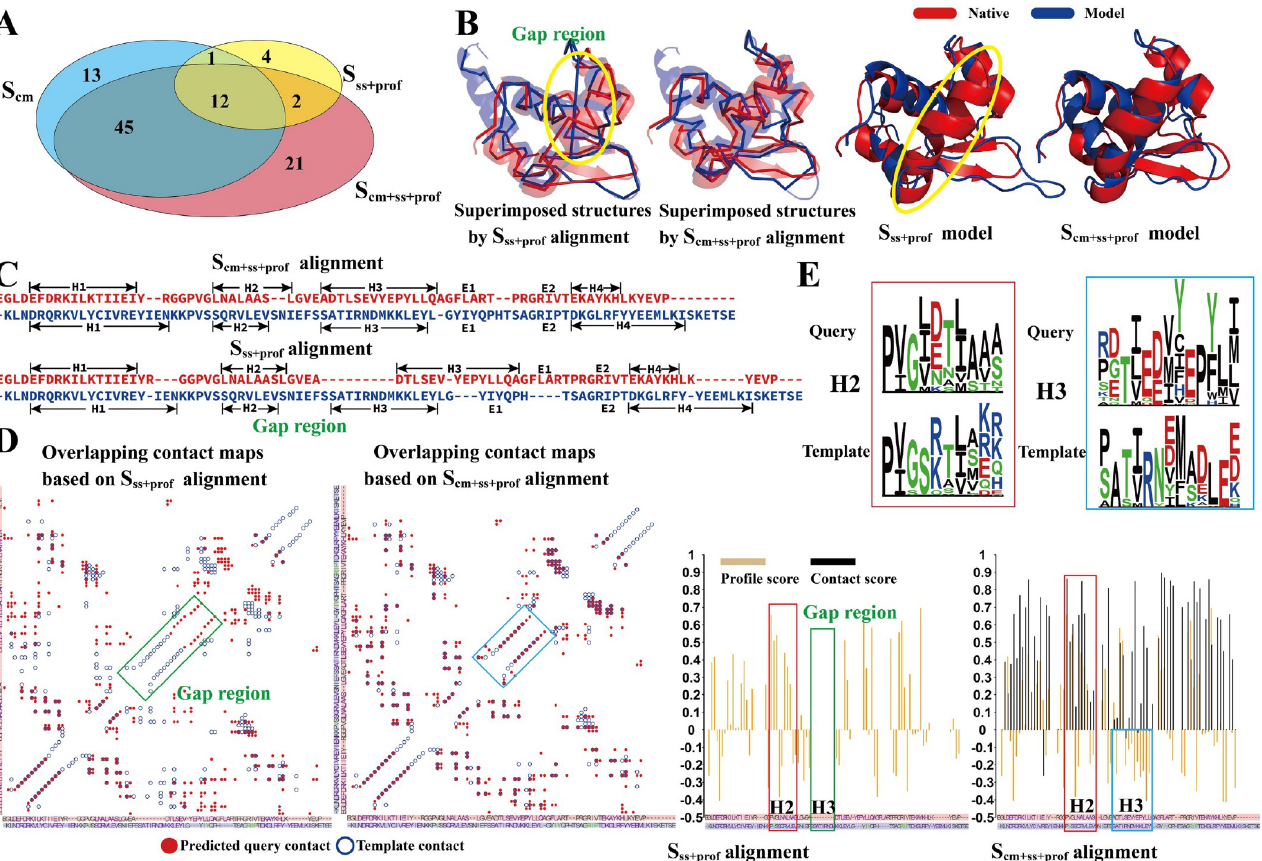
Fig 3. Performance of CEtheader on the 211 Hard targets in Benchmark Set-I from the I-TASSER database. (A) Venn diagram for the number of targets with first template TM-scores > 0.5 using different scoring functions. (B) Overlay of the CEthreader template (left panel) and MODELLER models (right panel) on the native structure from the RuvB Holliday junction branch migration motor (PDB ID: 1in4A1), where two scoring functions- S ss + prof and S cm + ss + prof - were used by CEthreader. (C) Query-template alignments using different scoring functions for 1in4A1, where H1-4 and E1-2 are secondary structure segments assigned from the native PDB structure. (D) Overlay of the query (open circles) and template (closed circles) contact maps obtained using S ss + prof (left panel) or S cm + ss + prof (right panel), where helix, strand and loop regions are marked with purple, green and grey characters along the sequences. (E) Contribution of profile- (yellow) and contact-based (black) scores to the CEthreader alignments when using S ss + prof (left) or S cm + ss + prof (right).